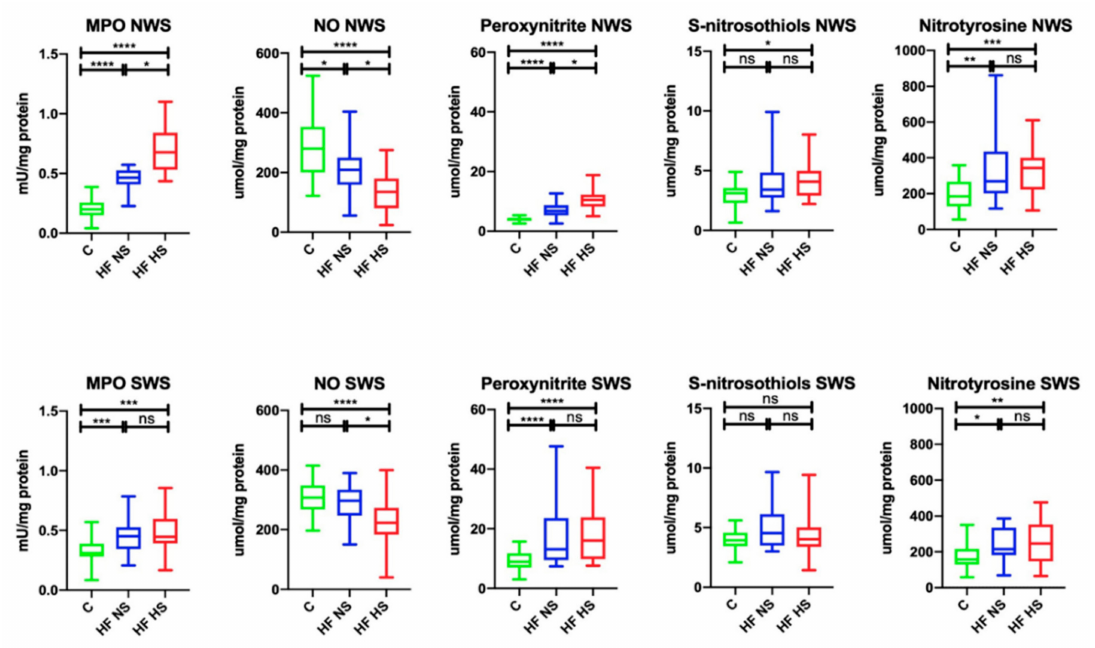
Figure 4. Salivary nitrosative stress in non-stimulated and stimulated saliva of HF patients and the control group. Abbrevia- tions: HF NS—heart failure with normal salivation; HF HS—heart failure with hyposalivation; MPO—myeloperoxidase; NO—nitric oxide; NWS—non-stimulated whole saliva; SWS—stimulated whole saliva; * p < 0.05, ** p < 0.01, *** p < 0.001, and **** p < 0.0001.